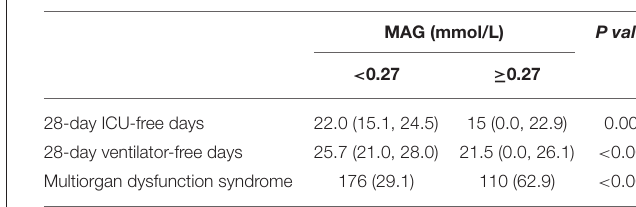
TABLE 6 | Effect of Glucose variability on 28-day ICU-free days, 28-day ventilator-free days, and multiorgan dysfunction syndrome [M(IQR)/ n